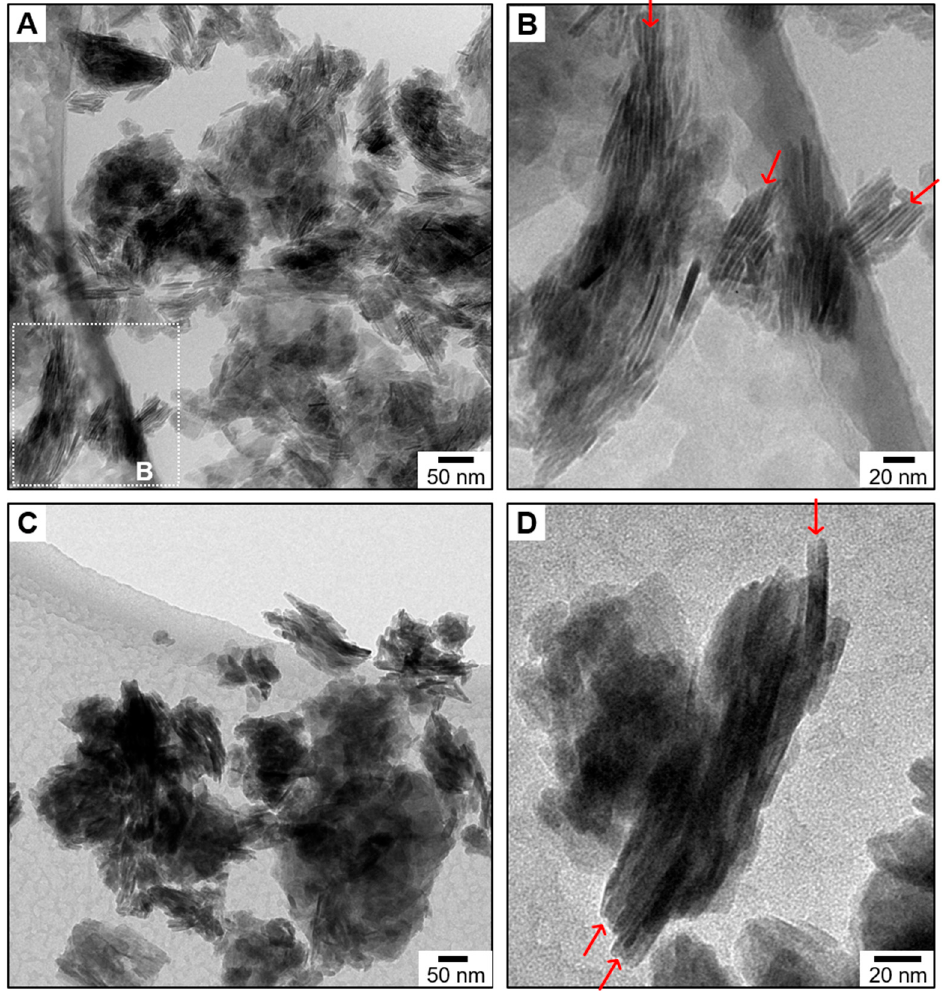
Figure 3. Behavior of the bone-like hydroxyapatite particles in water. ( A , B ) Representative cryogenic transmission electron micrographs (cryo-TEM) of the synthetic Carbonated HydroxyApatite (CHA) platelet-shaped particles dispersed in water. ( B ) shows a magnification of the rectangle region marked by the white dashed-line drawn in ( A ). The red arrows indicate the presence of narrow contrasted gaps in between CHA particles. Representative transmission electron micrographs (TEM) at low magnification ( C ) and at higher magnification ( D ) of the copper grid previously examined in cryogenic conditions in ( A , B ). The red arrows now indicate the absence of narrow contrasted gaps in between CHA particles.